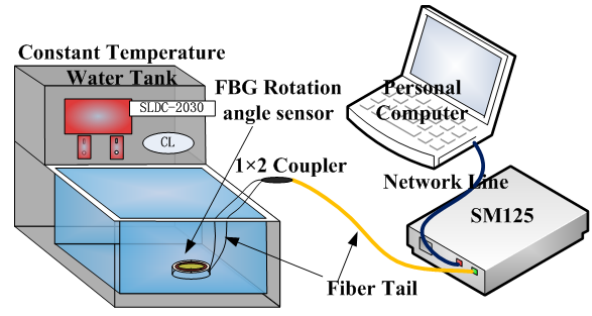
Fig. 6 Temperature calibration experimental platform.